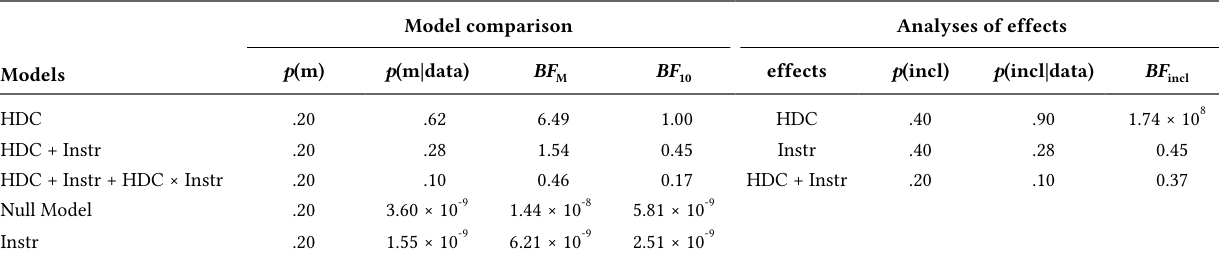
Results of the Bayesian Mixed Design ANOVA With the Within-Subject Factor Hundred-Decade Compatibility and Between-Subject Factor Instruction